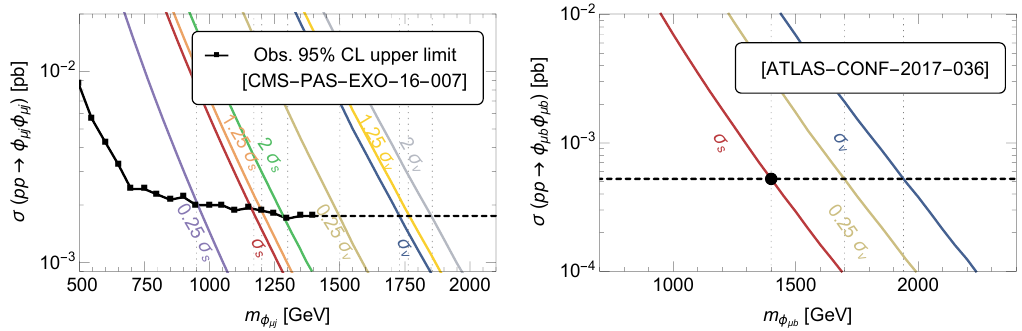
Figure 5 . ( Left plot ) Bounds on scalar and vector leptoquarks which decay to ( (cid:22)j )( (cid:22)j ) (cid:12)nal states. The observed 95% CL upper limit on the production cross section times branching fraction (black solid line) is taken from a search for leptoquarks in this (cid:12)nal state at CMS [9]. The search stopped at 1 : 4 TeV. In order to obtain a plausible estimate for the mass limit on vector LQs we extended the cross section limit beyond 1.4 TeV by assuming that it becomes mass-independent (black dashed line). The theoretical cross sections for di(cid:11)erent MLQs which can decay to ( (cid:22)j )( (cid:22)j ) (cid:12)nal states are shown as colored lines and labeled with corresponding cross sections. The intersects (vertical dotted lines) determine the lower limits on the MLQ masses. ( Right plot ) Bounds on scalar and vector MLQs which decay into ( (cid:22)b )( (cid:22)b ) (cid:12)nal states. Since only a 95% CL on the stop/leptoquark mass (black dot) is provided in [17] we cannot derive rigorous mass bounds on other LQs. To obtain an estimate, we assume that the experimental upper limit on the cross section is (cid:13)at across the LQ mass range and agrees with the value for the scalar (cid:12)ducial cross section, (cid:27) S , at the stop/leptoquark mass limit (black dashed horizontal line). Cross sections for other MLQs that can decay into ( (cid:22)b )( (cid:22)b ) (cid:12)nal states are shown as colored lines and labeled with their cross sections. The intersects (vertical dotted lines) determine our estimates for lower limits on the MLQ